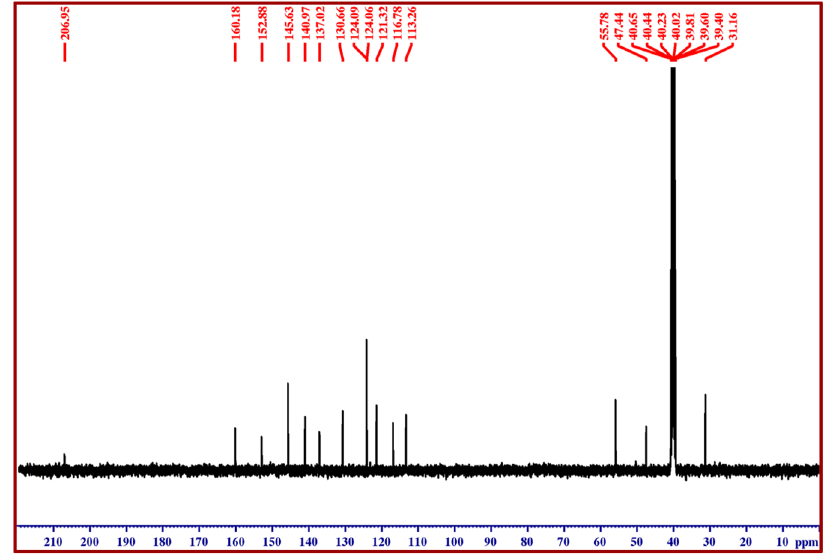
Figure 6. 1 H Nuclear magnetic resonance for MMPI crystal.